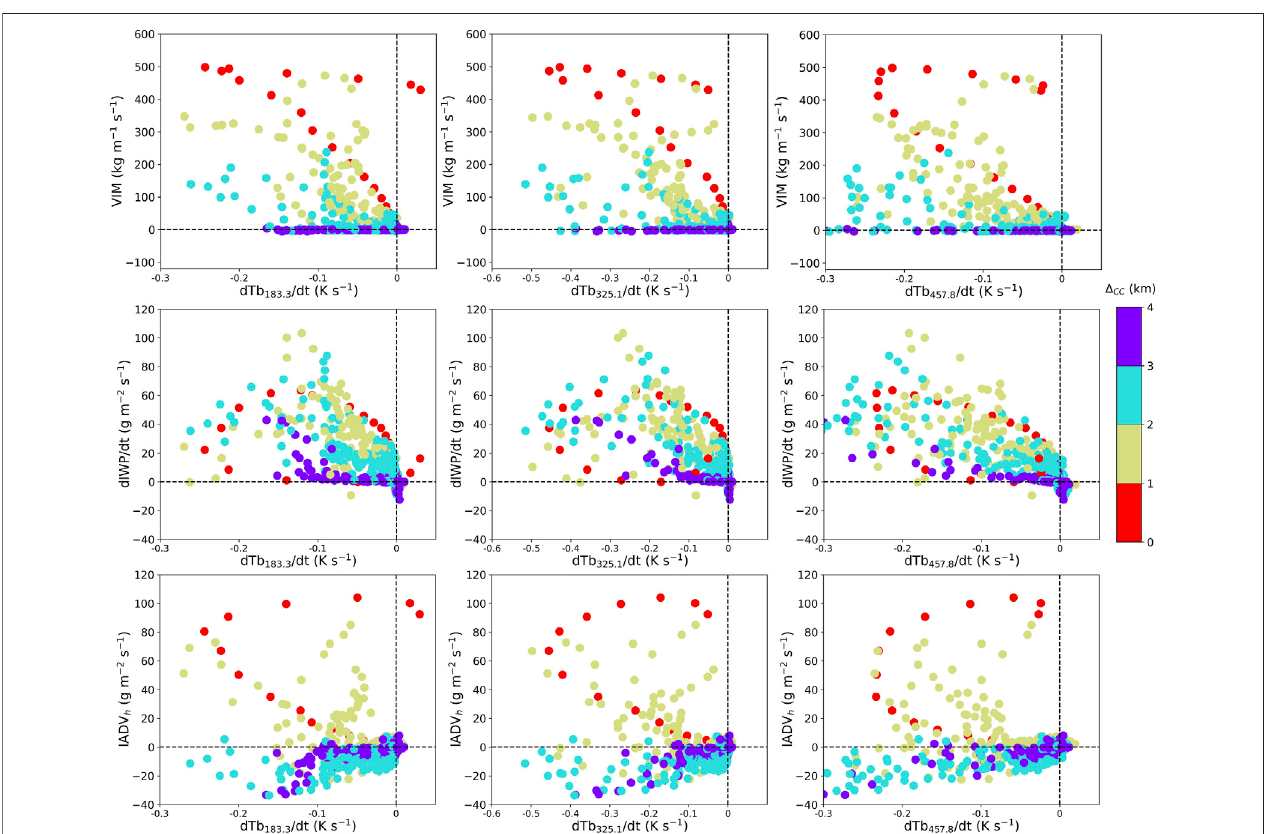
FIGURE6| ScatterplotofVIM,dIWP/dt,andIADV h (fromtoptobottom)vs.dTb/dtusinga1-minintervalforthe183.3,325.1,and457.8 GHzchannels(fromleftto right) for CC-H (3h02 to 3h12). The color code indicates the horizontal distance to the convective core.